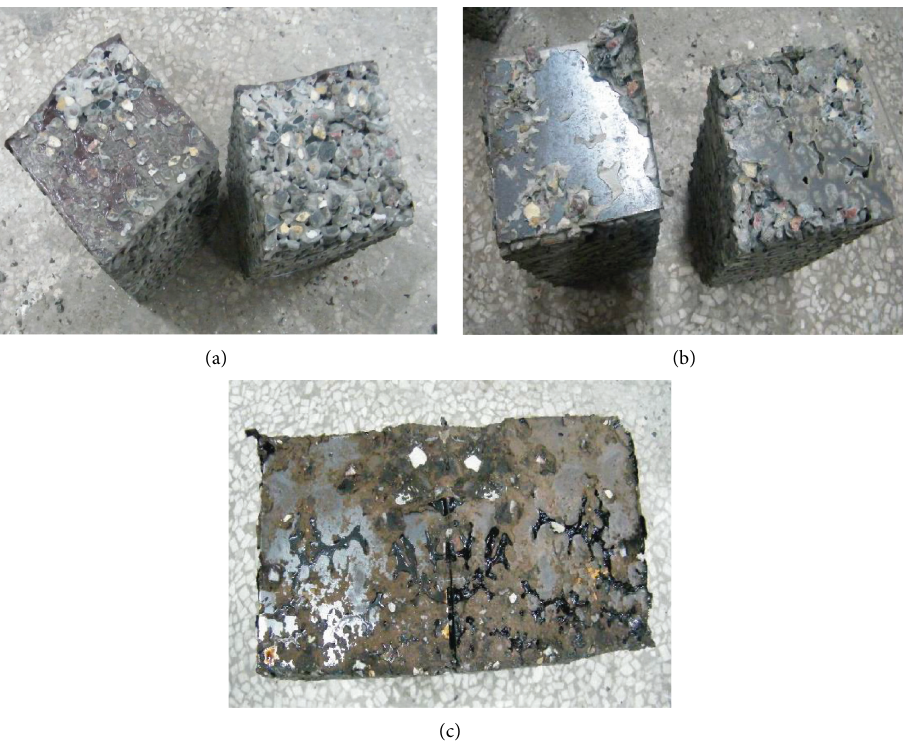
Figure 4: Flexural failure status of different interface binders. (a) Self-made polymer steel interface binder, (b) common epoxy resin, (c) epoxy asphalt.